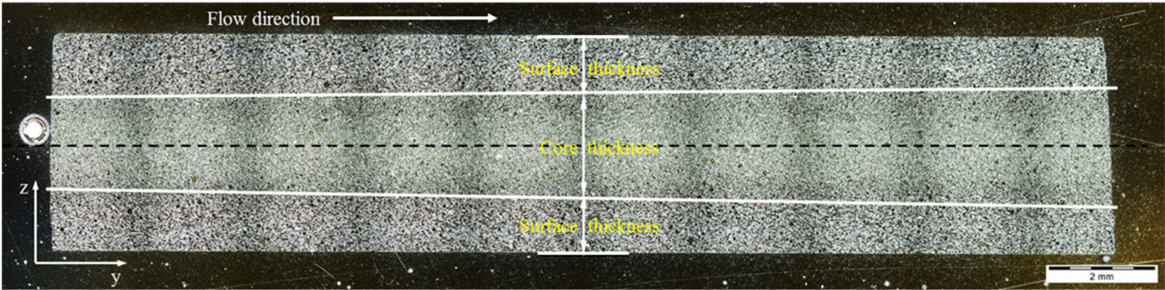
Figure 12. Fiber oriented under the surface of the molded